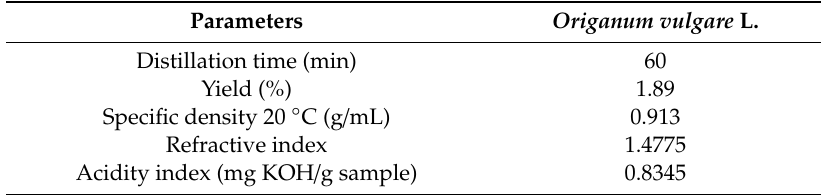
Table 1. Physicochemical characteristics of Origanum vulgare essential oil from Putre,